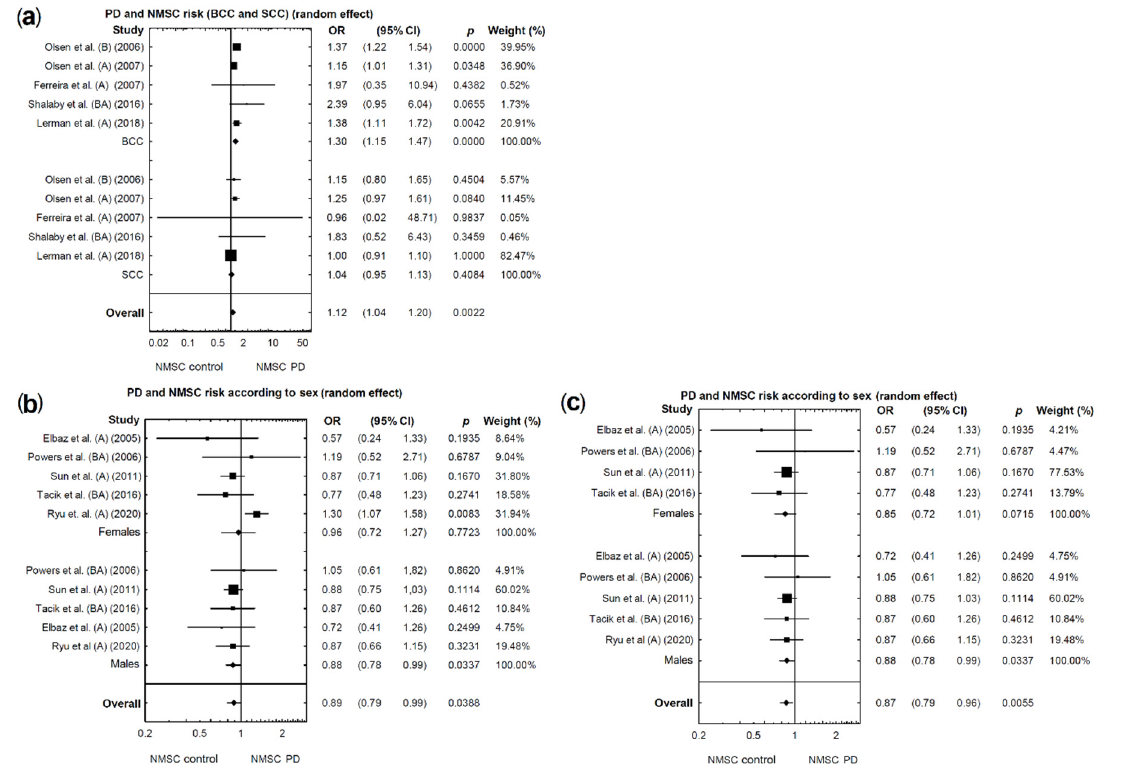
Figure 4. ( a ): Forest plot of pooled studies of BCC and SCC occurrence in PD patients. ( b ) Forest plot of pooled studies of NMSC occurrence in PD patients according to sex. ( c ) Forest plot of pooled studies of NMSC occurrence in PD patients according to sex—studies causing high heterogeneity excluded. Each line represents an individual study result, with the width of the horizontal line indicating a 95% confidence interval (CI) and the position of the box representing the point estimate OR (odds ratio) (B—NMSCs before PD diagnosis, A—NMSCs after PD diagnosis, BA—NMSCs diagnosed before or after PD diagnosis.